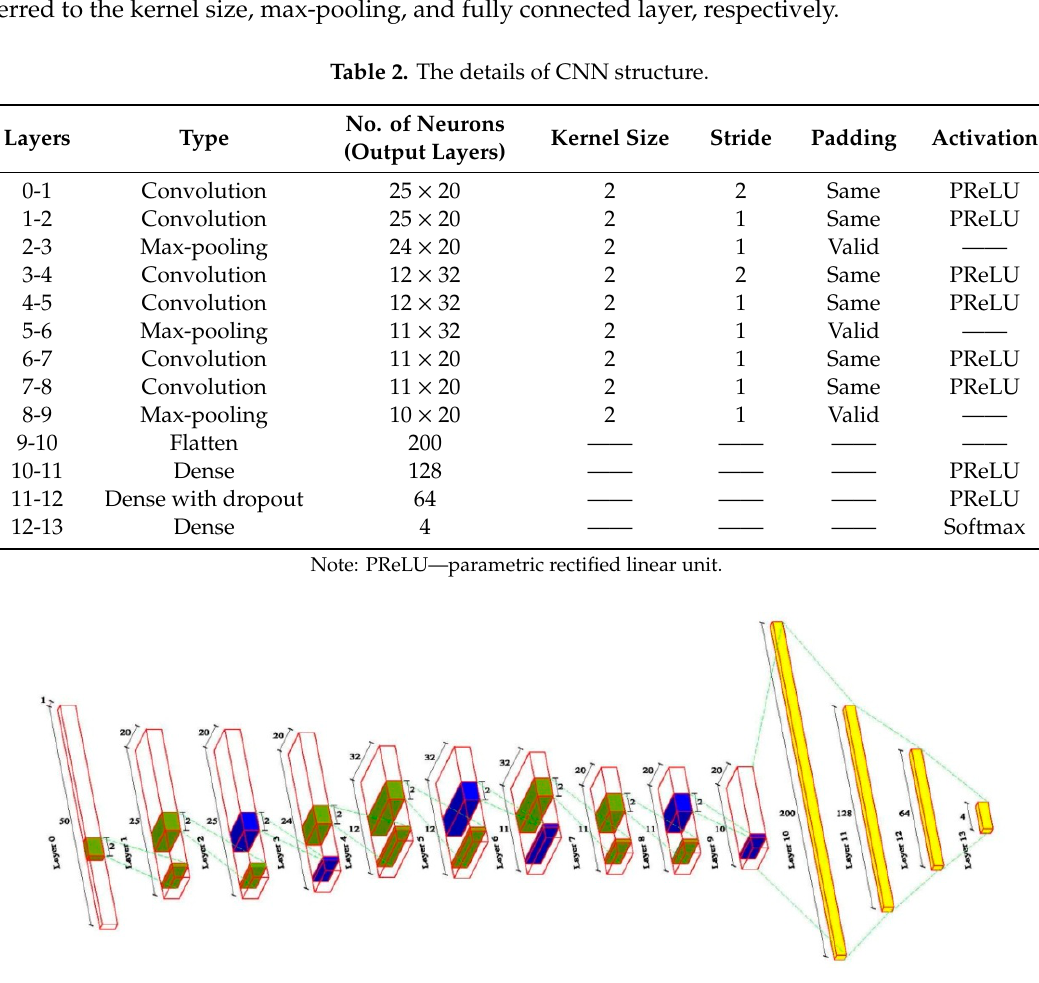
Figure 8. The proposed deep CNN architecture.